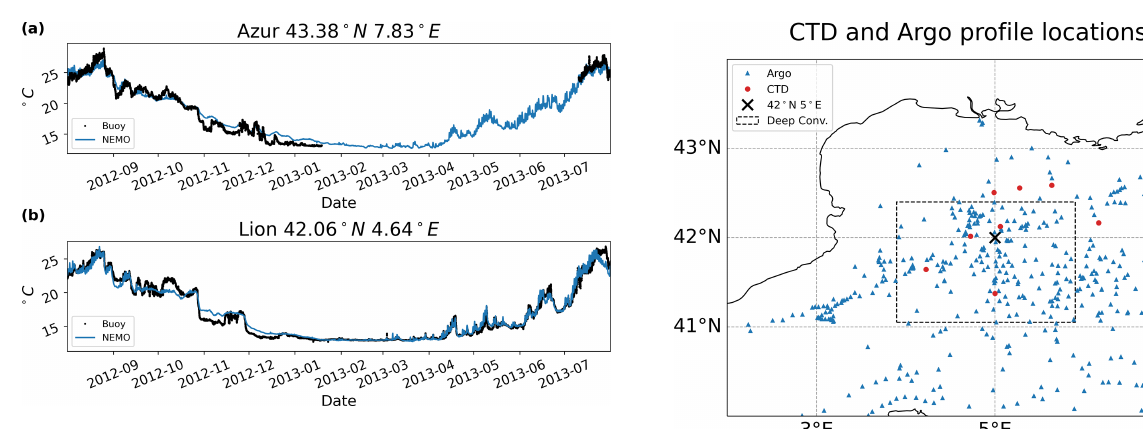
Figure 3. SST comparison between the NEMO control run and the Azur (a) and Lion (b) buoy SST datasets. Where the data are avail- able, the model results match the buoy data fairly well.